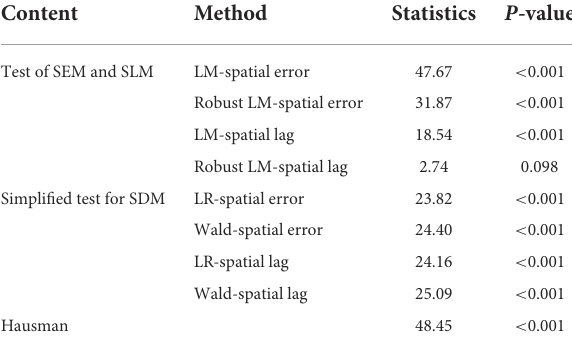
TABLE 6 The results of identification tests of spatial econometric